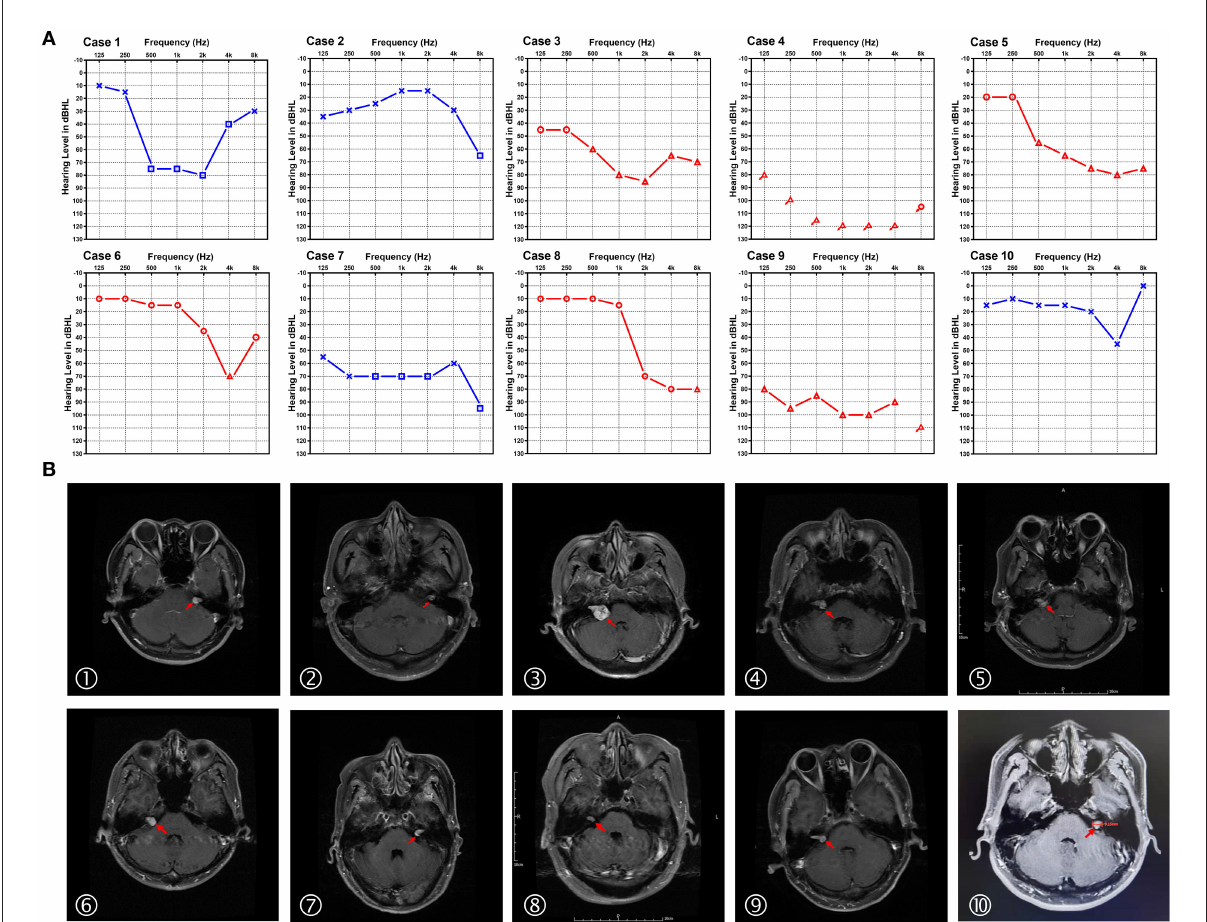
FIGURE1 Audiograms and MRI image of the 10 patients with sudden sensorineural hearing loss (SSNHL) and acoustic neuroma (AN). (A) Pure-tone audiograms of the affected ear of the 10 patients with acoustic neuroma at the diagnosis of sudden sensorineural hearing loss (air conduction). The red line represents the right ear and the blue line represents the left ear. (B) The axial cranial MRI of the 10 patients diagnosed with acoustic neuroma in our study. Red arrows indicate the tumor